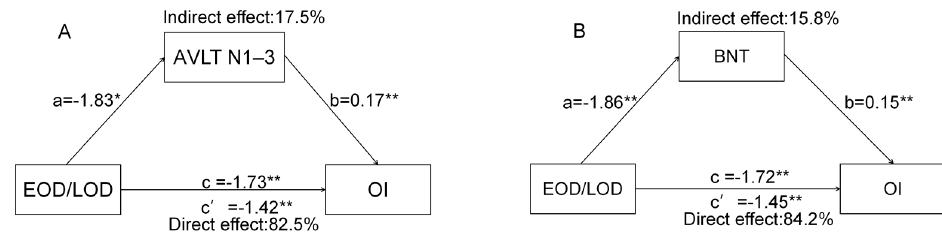
Figure 3. The mediating effect of cognitive function on the OI scores of EOD/LOD groups. ( A ) AVLT